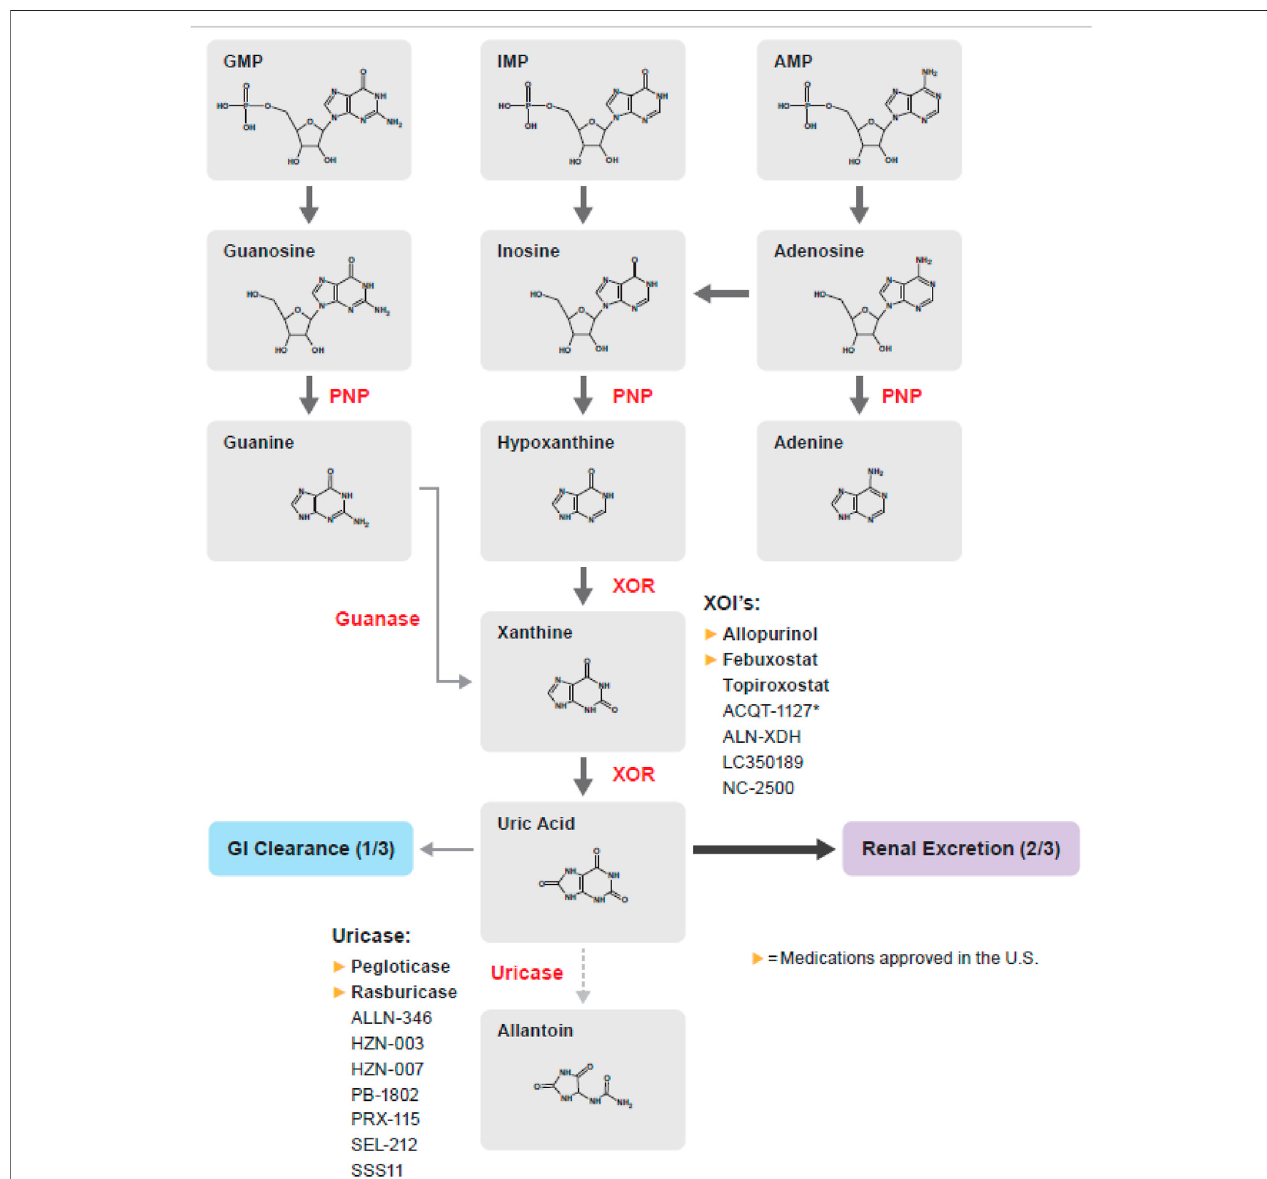
FIGURE 1 | Purine metabolism pathway; medications in bold are approved by the FDA, EMA, or PDMA. AMP, Adenosine monophosphate; GMP, Guanosine monophosphate; IMP, Inosine monophosphate; PNP, Purine nucleoside phosphorylase; XOR, Xanthine oxidoreductase.